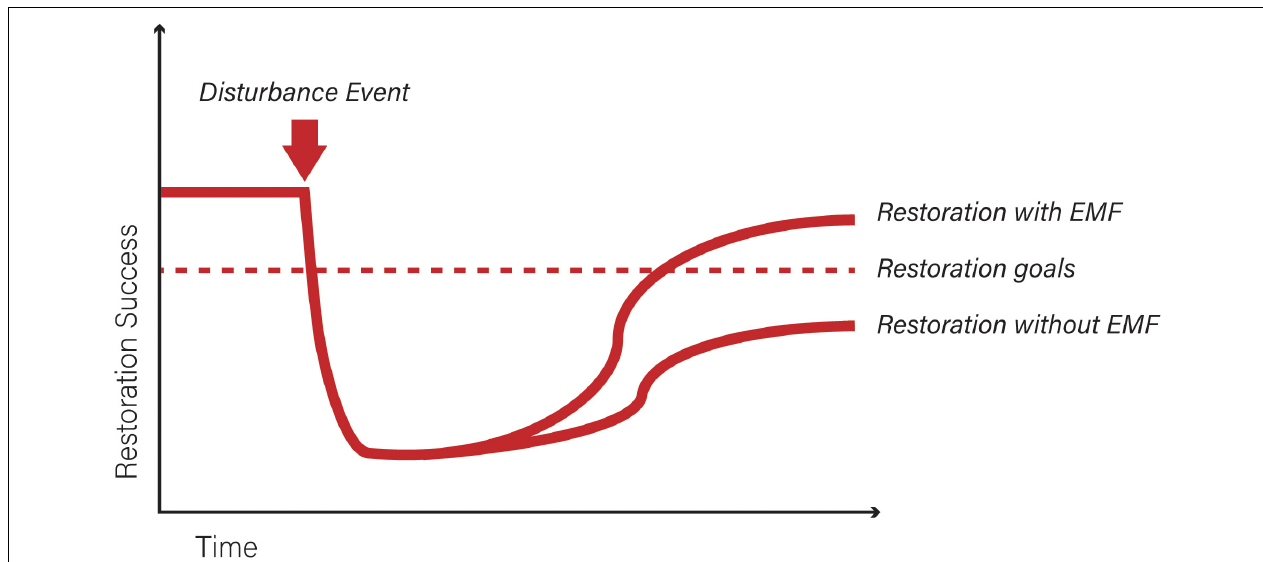
FIGURE 3 | Conceptual model showing restoration success over time. The arrow indicates a disturbance event. The dotted line representstargeted restoration goals at the time of implementation. After a natural or anthropic disturbance event disrupts the original community, a restoration plan is implemented, establishing restoration goals (e.g., restoring specific ecosystem functions, reintroducing a particular species of interest). It is often impossible to recreate the pre-disturbance conditions and there is often a time lag between the initiation of restoration activities and the habitat response to that restoration plan (due to species or communities time to reoccupy suitable restored areas, and time to achieve measurable restoration effects). Although the shapes of the curves and the length of disturbance and success of restoration might be variable and difficult to measure, incorporating suitable EMF in restoration efforts can help increase the rate of restoration success due to increased survival and growth of specific plant hosts, and the improvement of soil properties (e.g., increase soil stability, decrease heavy metal toxicity). Restoration goals could be reached in a shorter amount of time after disturbance compared to a situation in which EMF are not considered and restoration fails to achieve the initial goals. Other trajectories not shown in the figure are possible: if the EMF species are not properly chosen, for example, long-lasting effects might not be attainable and instead of reaching a plateau when restoration goals are achieved, the curve would start decreasing. Monitoring over time is necessary to avoid possible undesired